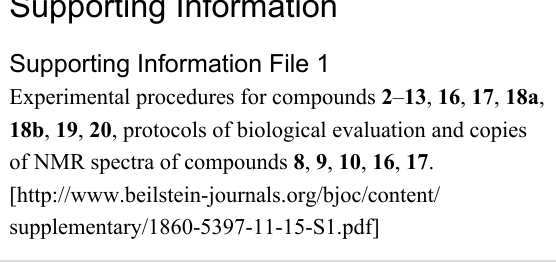
to strong tolerance-breaking immune responses and the produc- tion of selective IgG antibodies capable of binding to the native MUC1 antigen structures present on MCF-7 human breast cancer cells. Moreover, selective deoxyfluorination at the anti- genic carbohydrate determinant might be used to improve the metabolic stability of the saccharide epitope, as was showcased by the enhanced resistance of the 4’-deoxy-4’-fluoro-TF- antigen-threonine conjugate 12 towards enzymatic degradation by ß-galactosidase from bovine testes. Thus, the work presented herein is an example of the successful application of strategi- cally fluorinated glycopeptide derivatives as a tool to improve the immunogenicity and bioavailability of synthetic antigens and vaccines without affecting the induced antibody response and